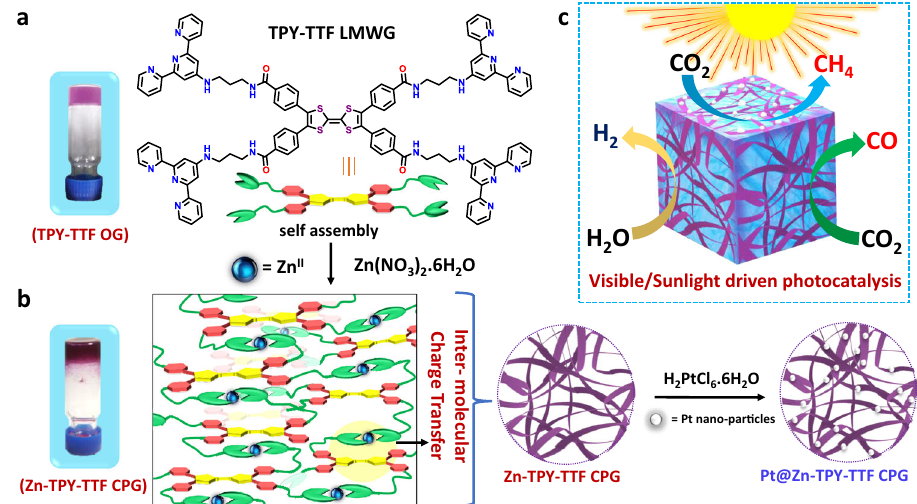
Fig. 1 Schematic presentation of visible/sunlight-driven photocatalysis in TTF-based coordination polymer gel (CPG). a TPY-TTF low molecular weight gelator (LMWG) based linker and corresponding organogel (TPY-TTF OG). b Self-assembly with Zn II toward the preparation of Zn-TPY-TTF CPG and preparation of Pt@Zn-TPY-TTF CPG by in situ stabilization of Pt nanoparticles on the Zn-TPY-TTF CPG. c Visible/sunlight-driven photocatalytic activity of Zn-TPY-TTF CPG and Pt@Zn-TPY-TTF CPG towards H 2 evolution and CO 2